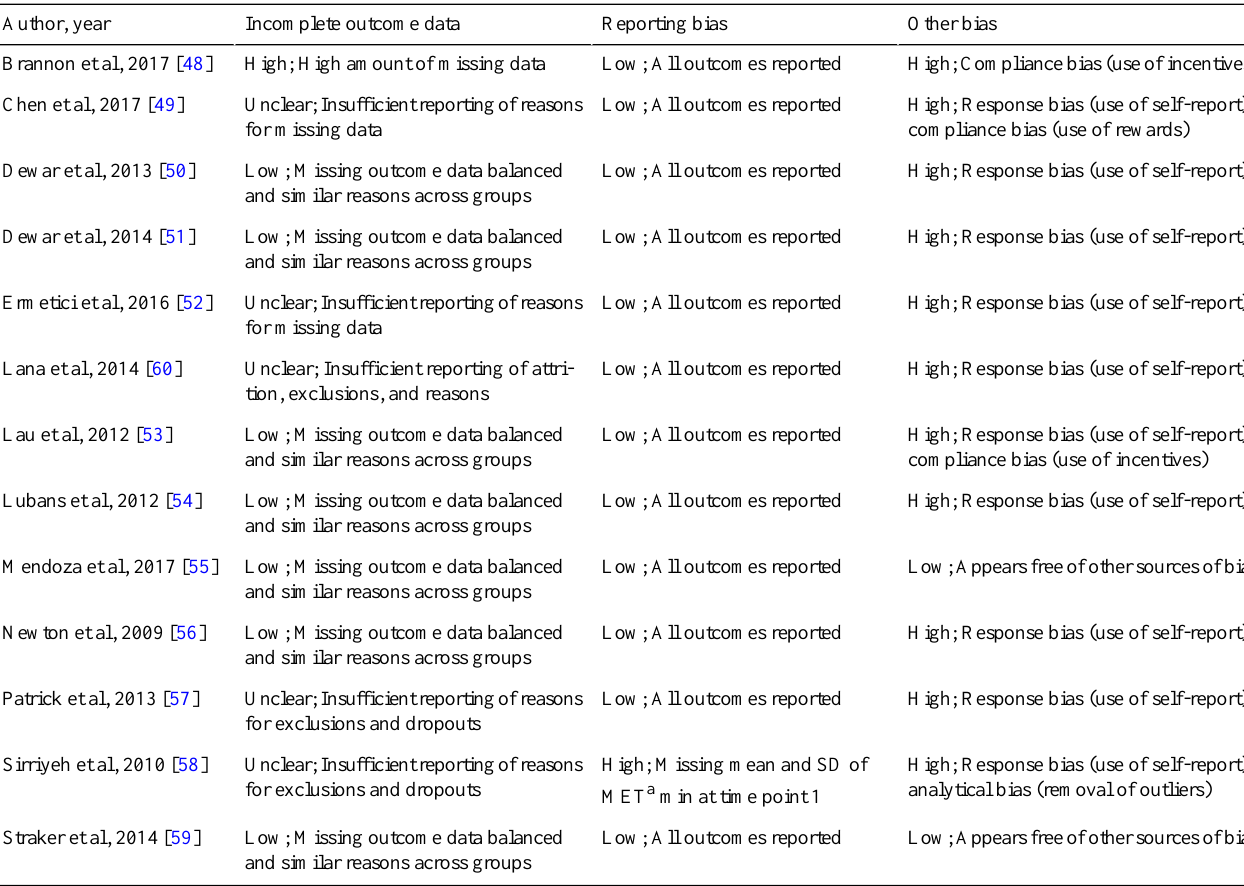
for missing and similar reasons across and similar reasons across for missing tion, exclusions, and and similar reasons across and similar reasons across and similar reasons across and similar reasons across for exclusions and 1Unclear; Insufficient reporting of reasons for exclusions and and similar reasons across